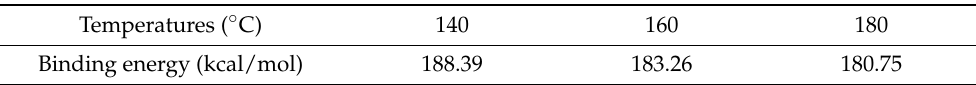
Table 2. Binding energy of corrosion inhibitor and iron surface in aqueous solution at different